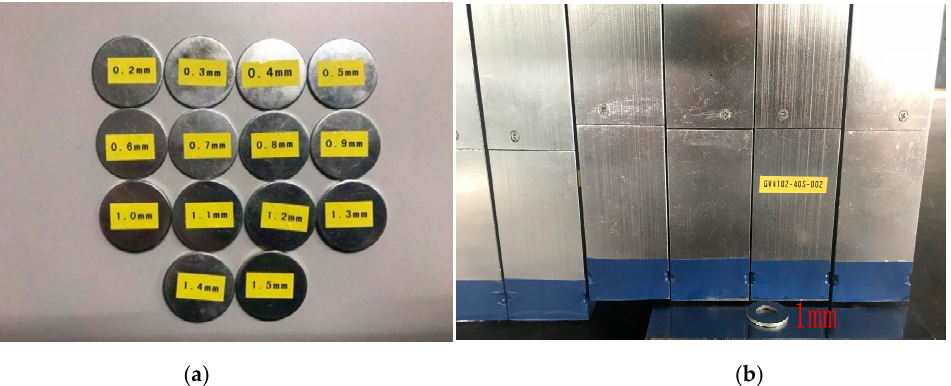
Figure 18. Measurement experiment tools and effect diagram. ( a ) The measuring tools. ( b ) The effect diagram.